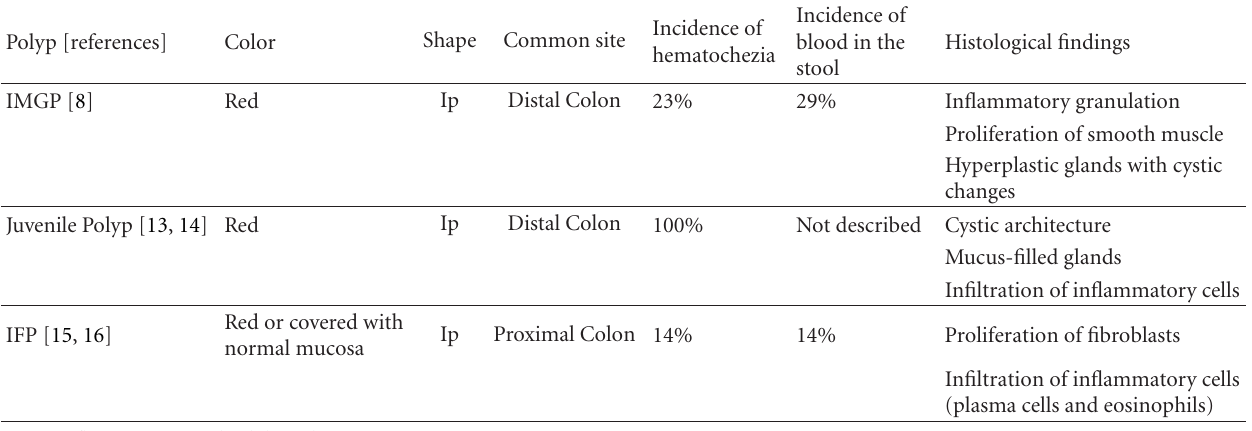
Table 1: Characteristics of inflammatory myoglandular polyp, juvenile polyp, and inflammatory fibroid polyp.